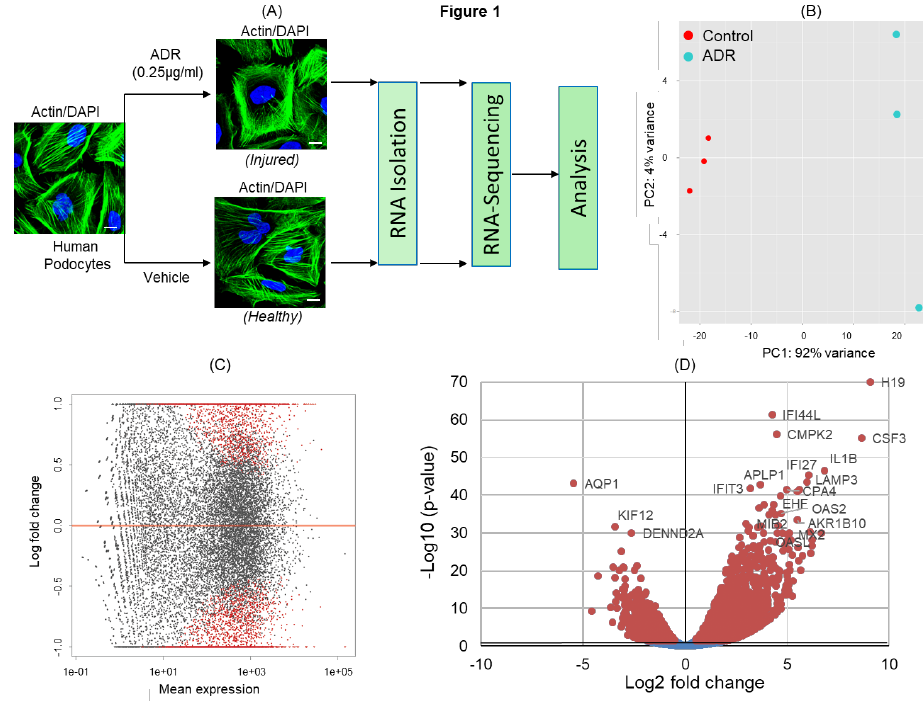
Figure 1. ( A ) Schematic of the experimental design for RNA-sequencing. Differentiated human podocytes treated with doxorubicin / adriamycin (ADR) or vehicle for 48 h were processed for